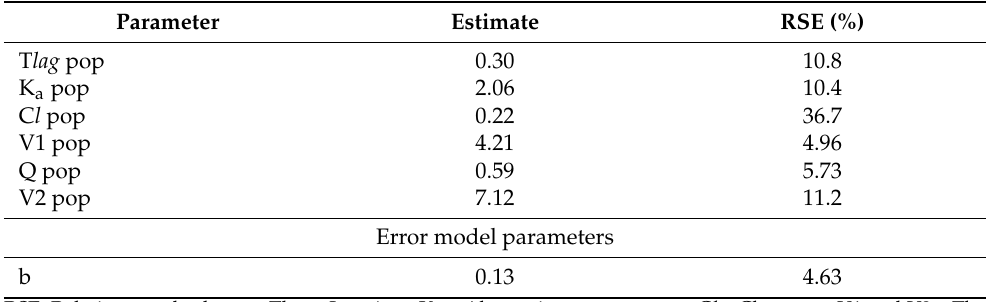
Table 5. Estimates of the population pharmacokinetic parameters from the final model.